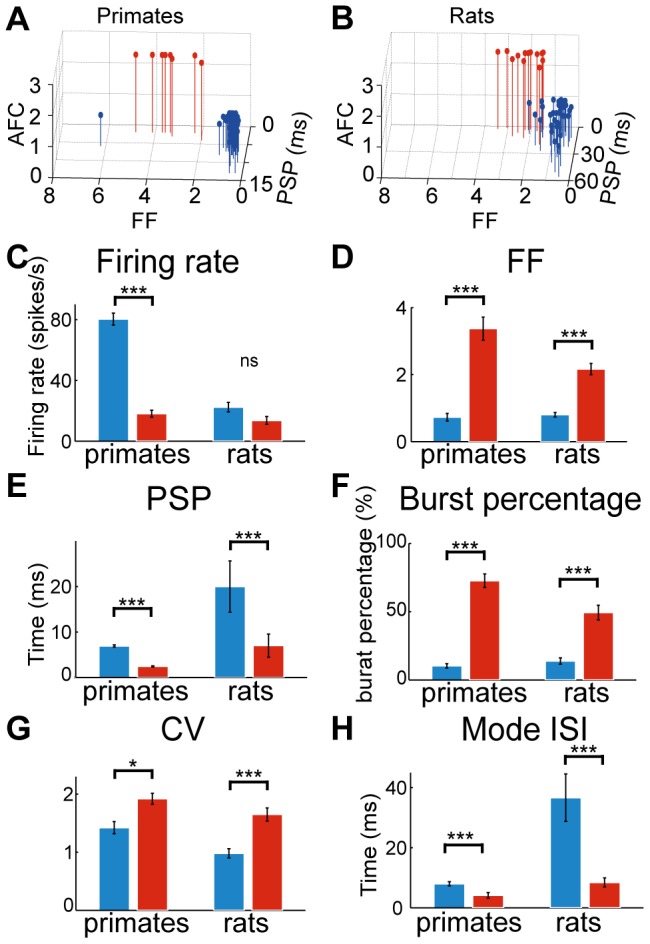
Neuronal classification and firing properties in primates and rats.A and B: 3 dimensional presentation of firing properties leading to the formation of distinct clusters in primates (A) and rats (B). C–H: Bar plots representing parameters of the two groups (HFP - blue, LFB - red) in the two species (left two bars - primates, right two bars - rats).